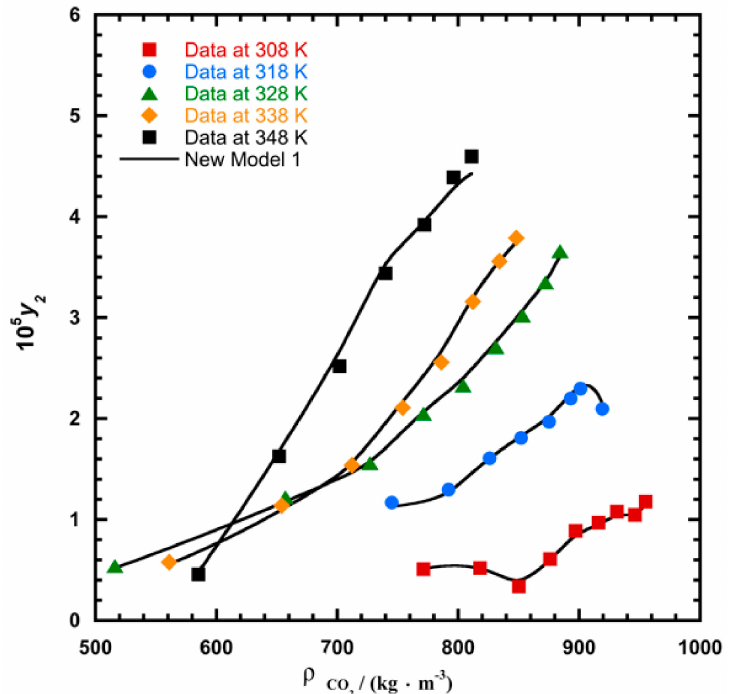
Figure 4. Plot of mole fraction ( y 2 ) as a function of density ρ /(kg.m − 3 ) for 1-amino-2,3-dimethyl-